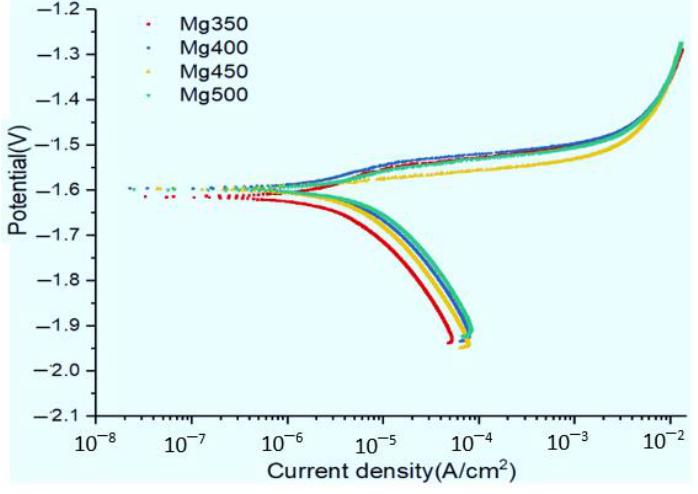
Figure 4. Polarisation curves of the different annealed conditions in Hank’s solution.